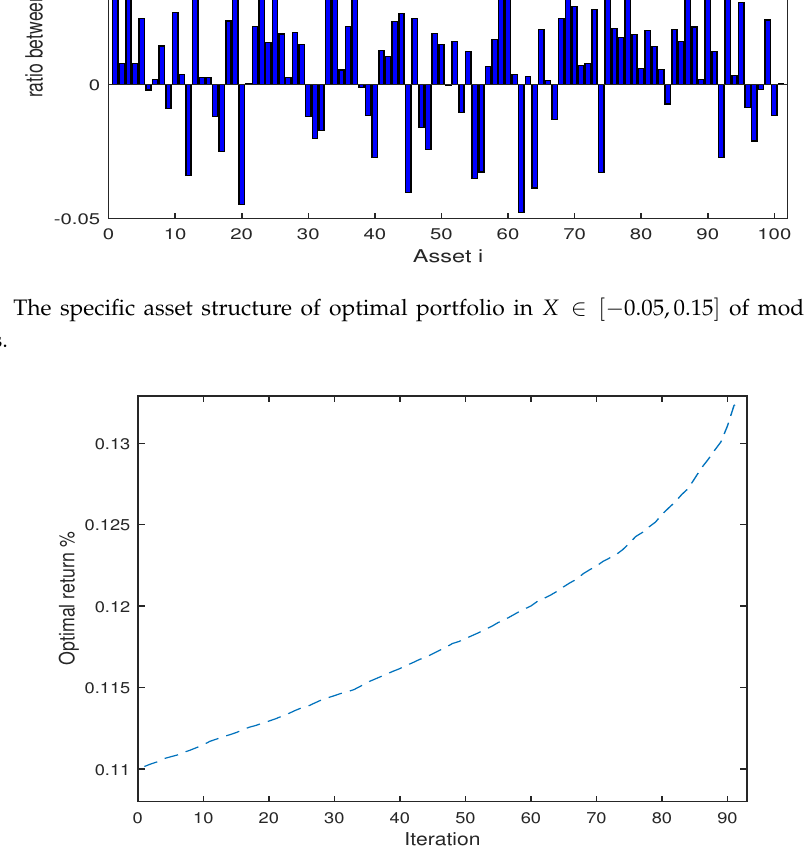
Figure 10. The return of optimal portfolio in different iterations in X ∈ [ 0,0.1 ] of model